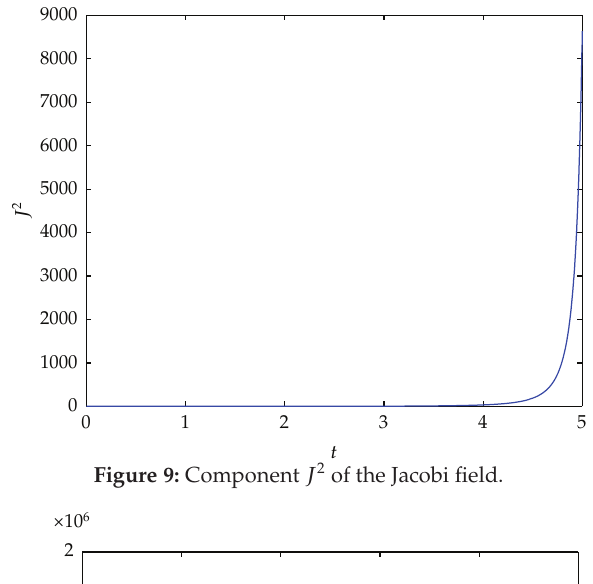
Figure 9: Component J 2 of the Jacobi field.